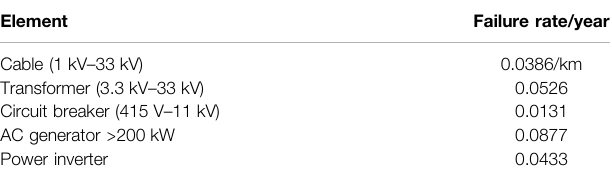
TABLE 1 | The failure rate of the main power network (Nemati et al., 2015; AME, 1992; Gill, 2011; Pascoe, 1978; Jeyapalan, 2007; SINTEF 1984; Ammirato et al., 2006; Zhou et al., 2012; YARD,